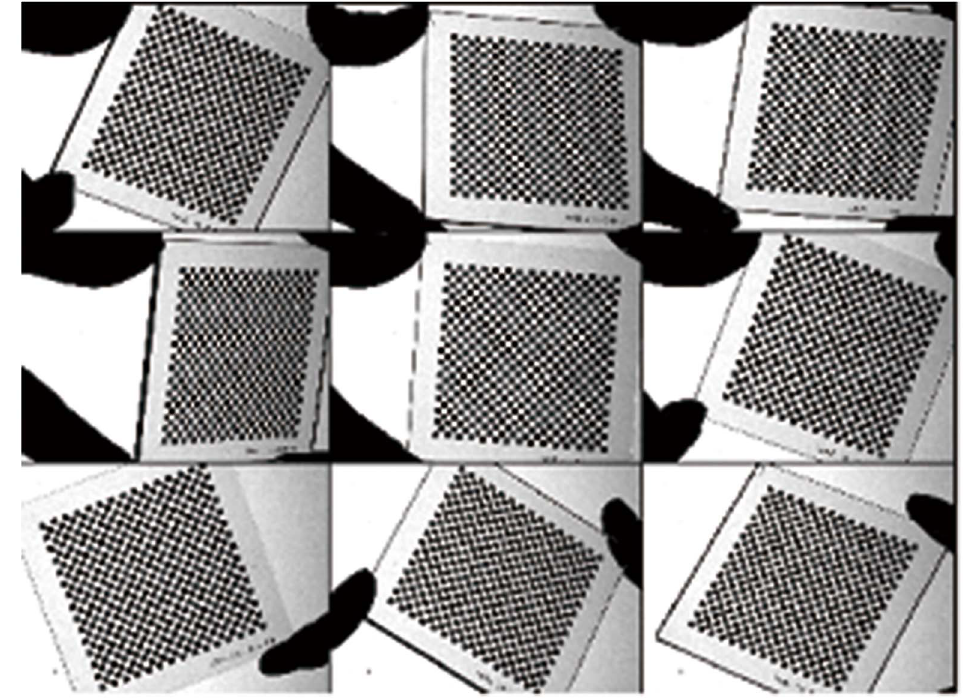
Figure 11. Calibration patterns for camera. doi:10.1371/journal.pone.0106911.g011 PLOS ONE |